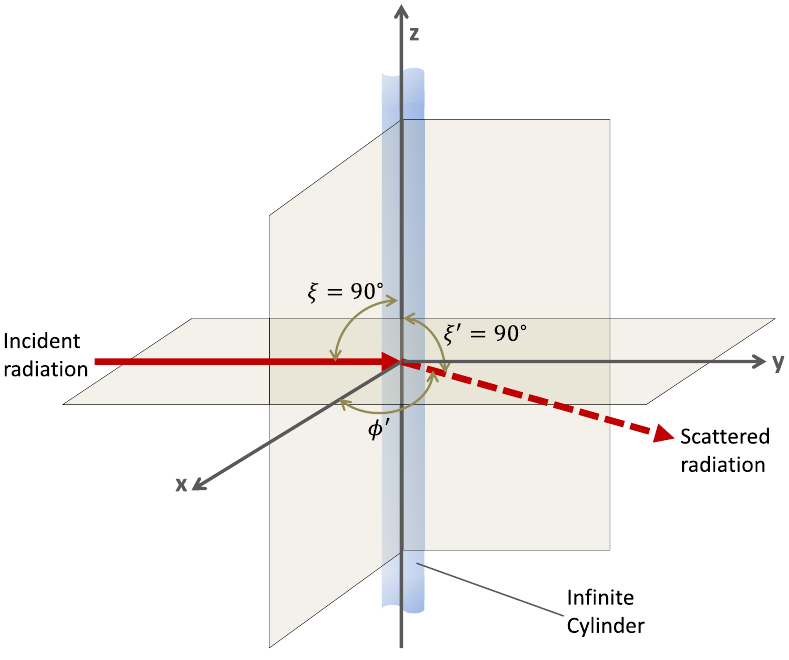
Figure 10. Schematic of the geometric configuration for the incident and scattered radiation from the infinitely long right-circular cylinder employed for the computation of the scattering and absorption resonances using 90 Mie theory. ζ ◦ is the angle of incidence for the radiation and φ ′ the scattering angle in the x - z =